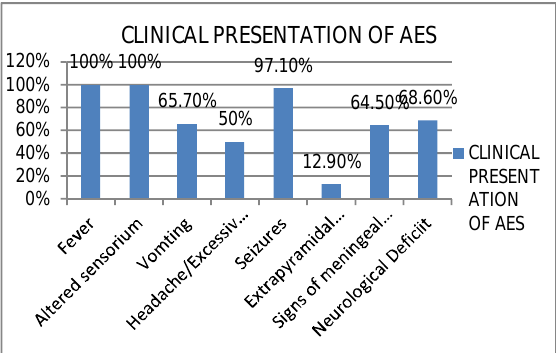
Figure 2: CSF findings in AES cases